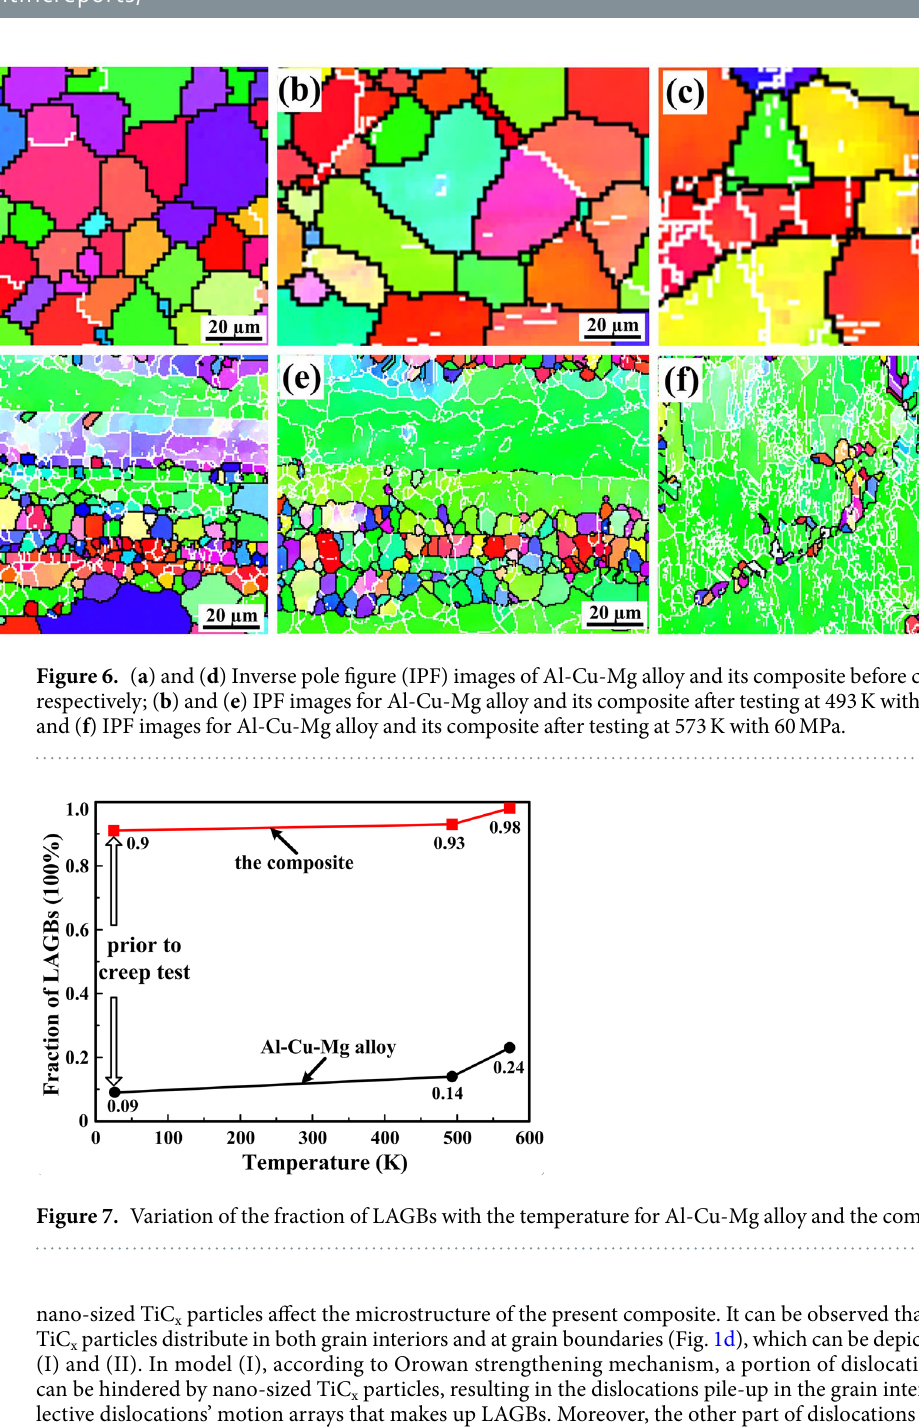
6 Scientific RepoRts | 7: 4540 | DOI:10.1038/s41598-017-04816-0